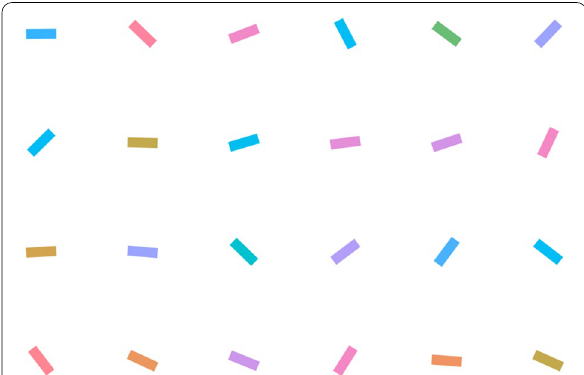
Fig. 3 Sample search display in Experiment 2. Note In Experiment 2, each search item has a changing color and rotating orientation, and any green or vertical targets must be detected. In this image, the second right-most item on the top row was a green color target (online demo available at: https:// louis khchan. github. io/ dynam ic_ search_